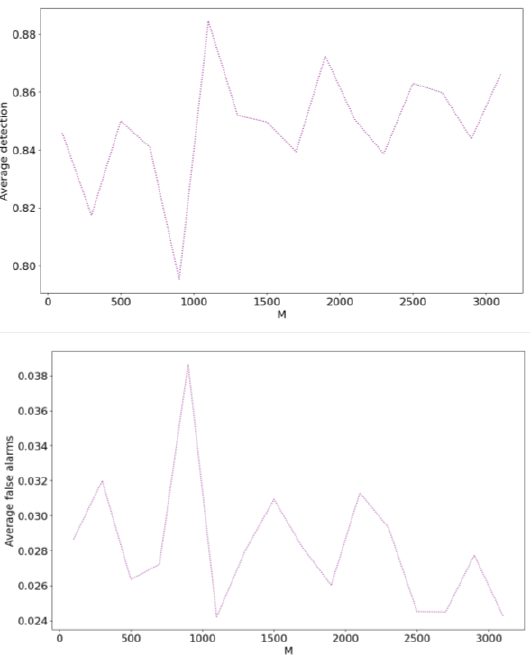
Figure 9. Values of average detection and average false alarms versus the number of dictionary atoms.